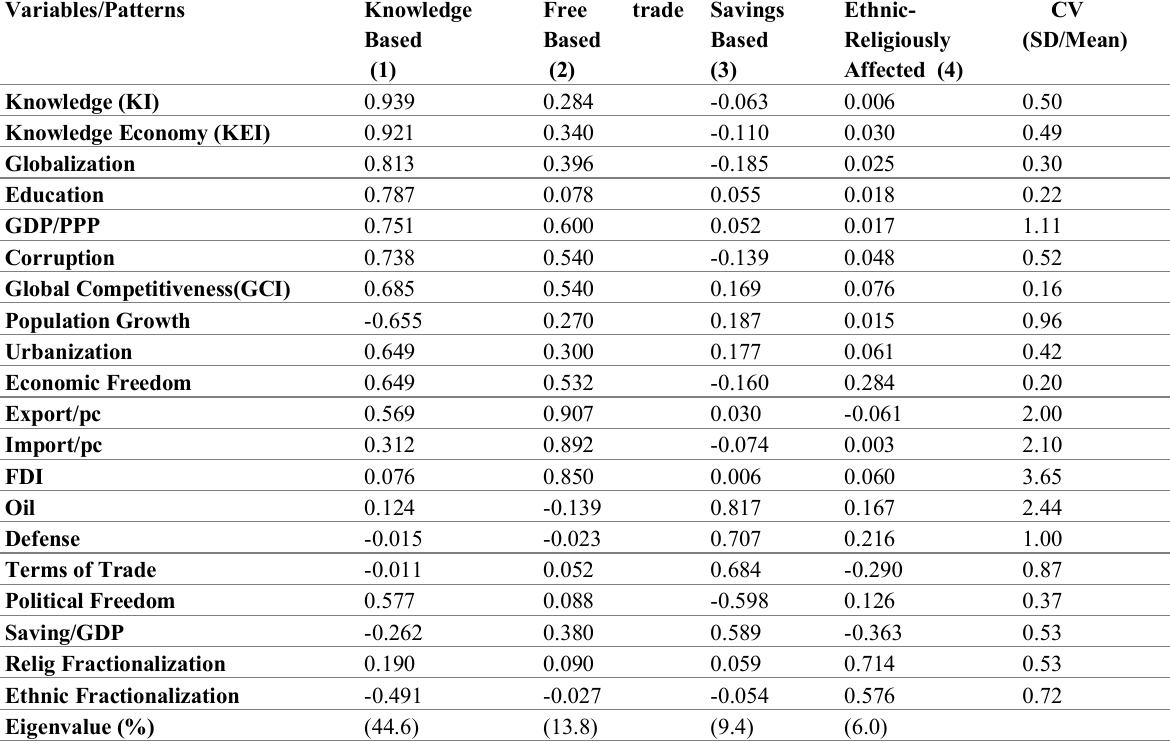
Table 4: Factor Analysis: Patterns of Economic